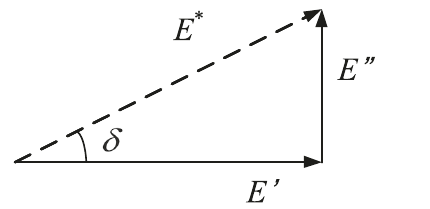
Fig. 1 Relationship among E 0 ; E 00 and tan δ . The loss factor tan δ is de fi ned as the ratio of the loss and storage